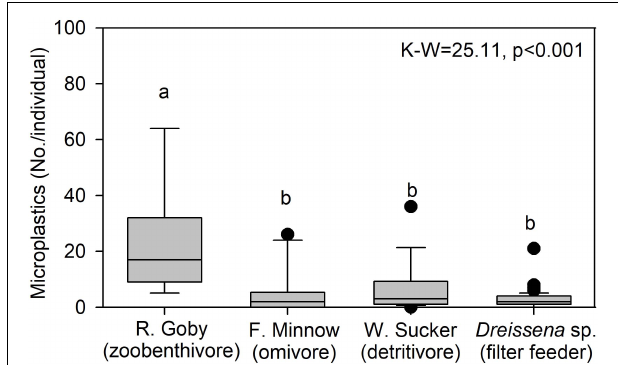
FIGURE 8 | Median (center line), 25th and 75th percentile (box edges), and data outliers beyond 25 and 75 percentiles (dots) for microplastic concentration in Neogobius melanostomus (round goby; zoobenthivore, N = 9), Pimephales promelas (fathead minnow; omnivore, N = 10), Catostomus commersonii (white sucker; detritivore, N = 16), and Dreissena sp. (mussels; filter feeders, N = 82, site River-6). The K–W are indicated, where degrees of freedom =3, and lowercase letters are not significantly different among taxa via post hoc comparison ( p ≤